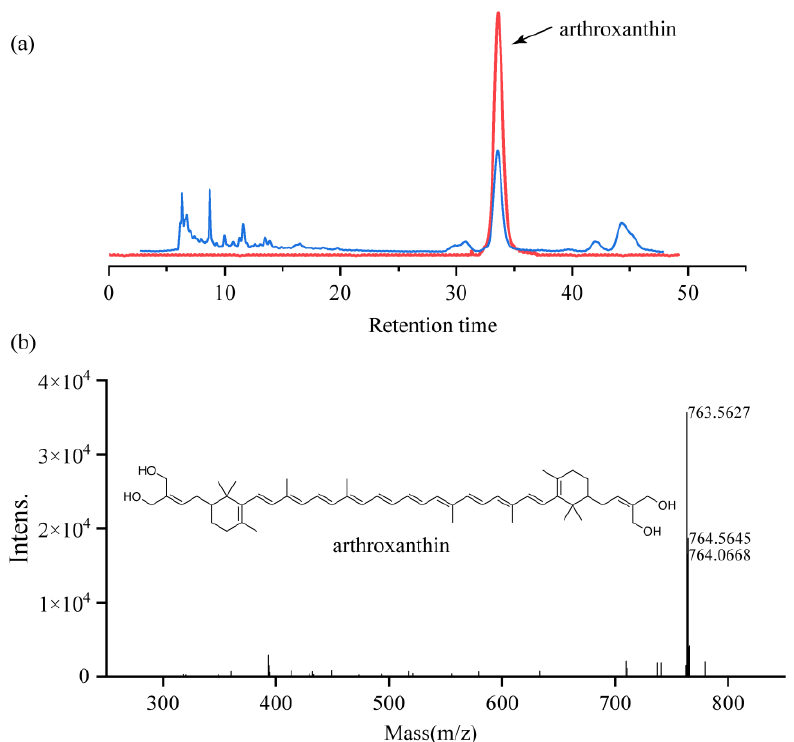
Figure 3. Purification and structural identification of arthroxanthin produced by QL17. ( a ) HPLC analysis of arthroxanthin. ( b ) MicrOTOF-Q analysis of arthroxanthin.